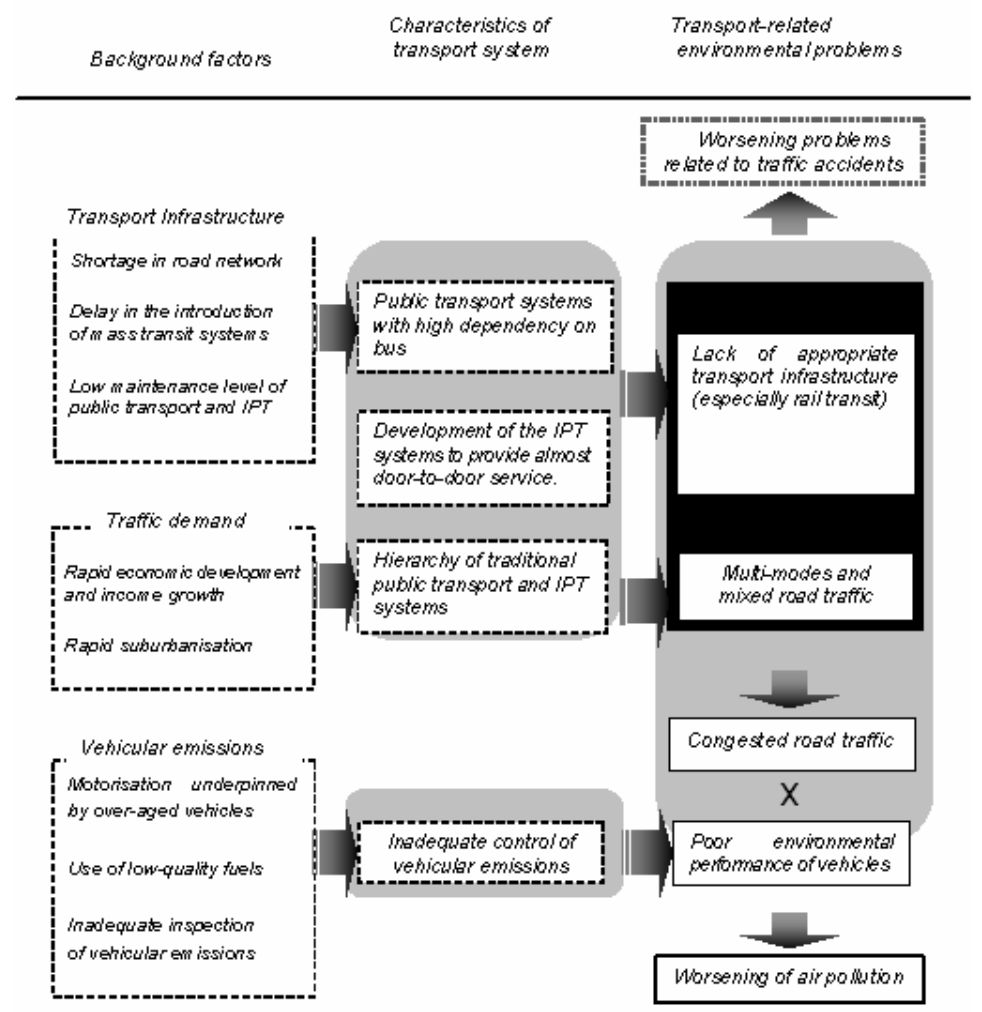
Figure 7. Mechanism of transport-related environmental problems in the Asian region for an integrated strategy, which includes not only emission standards, fuel standards, effective inspection and maintenance systems, but also transport planning and management. Figure 7 overviews the mechanism of current transport-related environmental problems in connection with background factors and characteristics of transport systems in the region. In the figure, the characteristics such as a) high dependency on bus and b) development of the intermediate public transport (IPT) systems to provide almost door-to-door service, are regarded as influential factors to environmental problems through bringing heavier